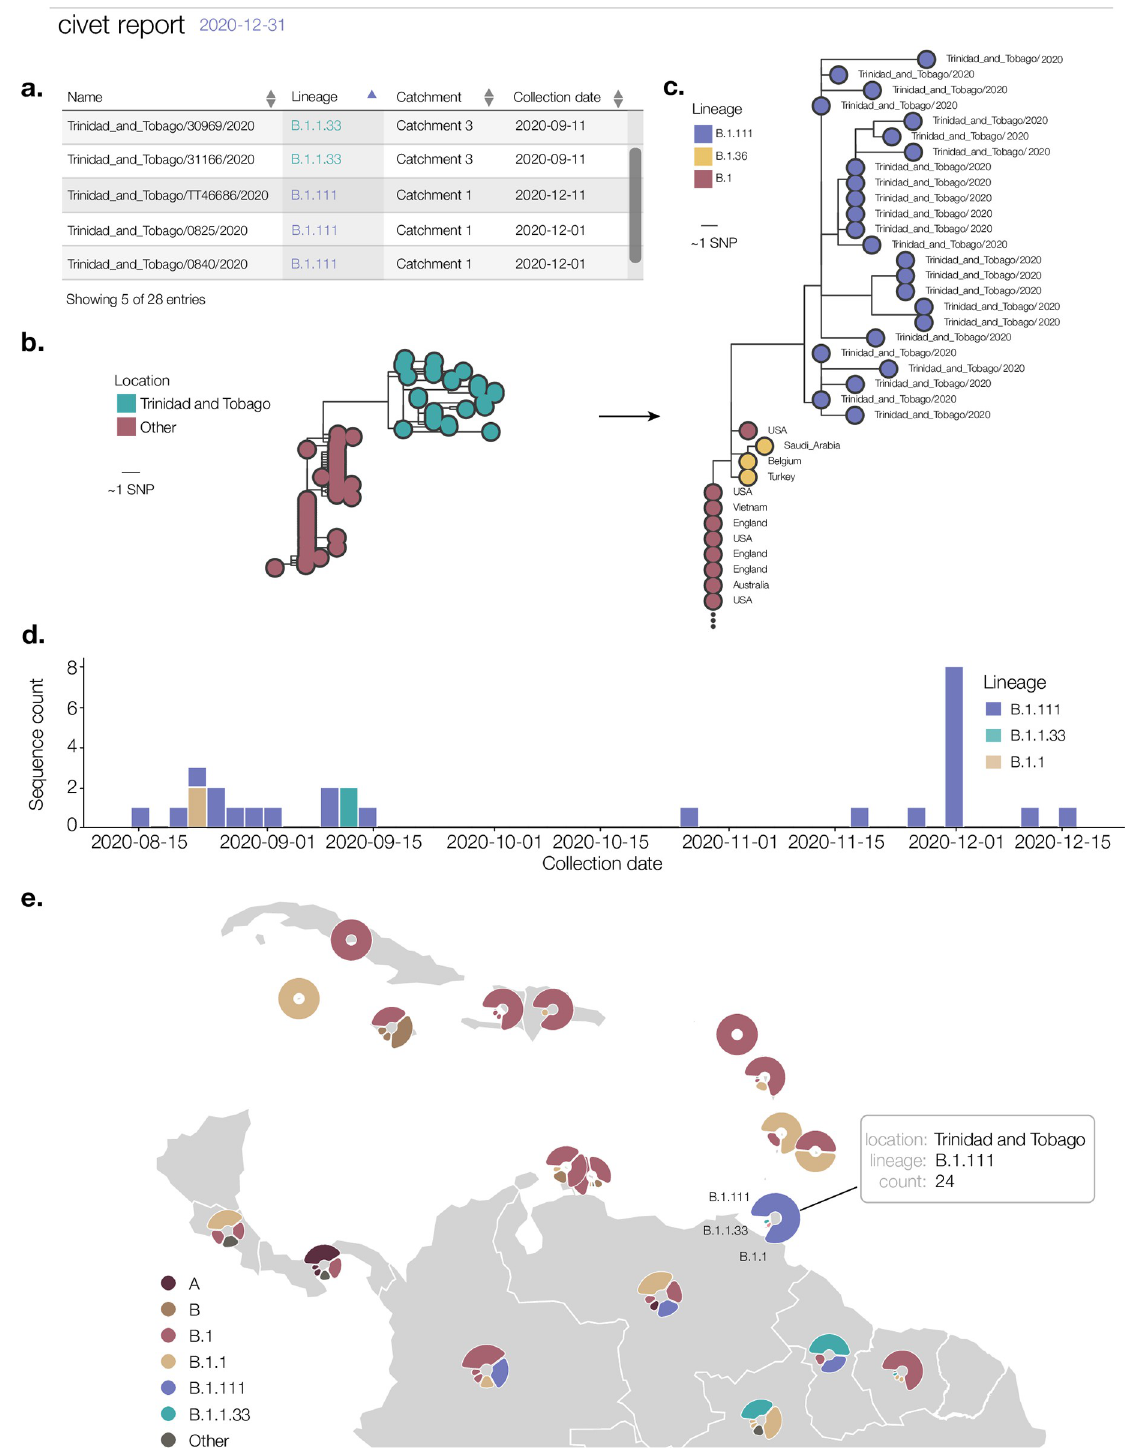
Fig 5. Schema of a national level surveillance report generated using civet for Trinidad and Tobago. All SARS-CoV-2 genome sequences on GISAID from 2020 with < 20% ambiguity content are summarised in the report (n = 28). a. Available metadata for query sequences from Trinidad and Tobago. Most genomes have been assigned lineage B.1.111, although a smaller number of genomes are assigned other lineages B.1.1.33 and B.1.1. b. Catchment 1 phylogeny. Query sequences are placed in the context of background diversity beyond Trinidad and Tobago. c. Expanding the phylogeny and colouring tips by lineage shows this catchment includes query sequences